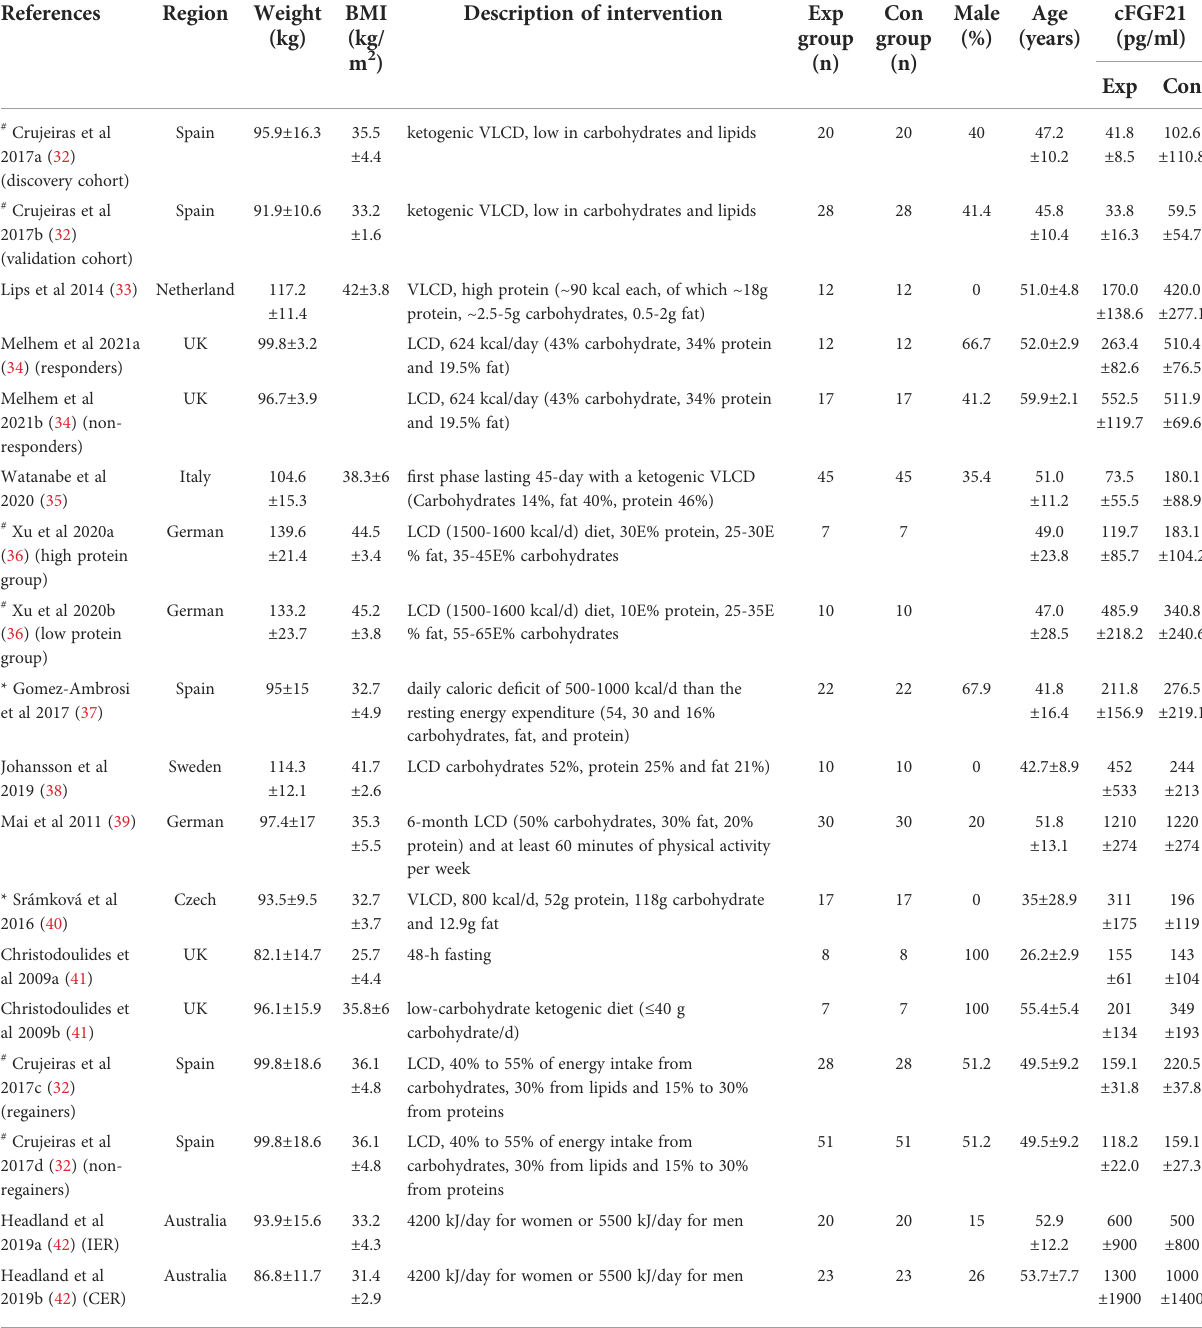
TABLE 4 Baseline characteristics of studies reported cFGF21 concentration in subjects with weight loss